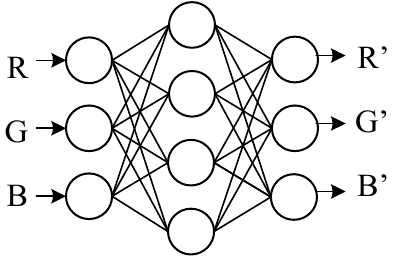
Figure 3. ANN to compute the new RGB coordinates according to the reference gamut.